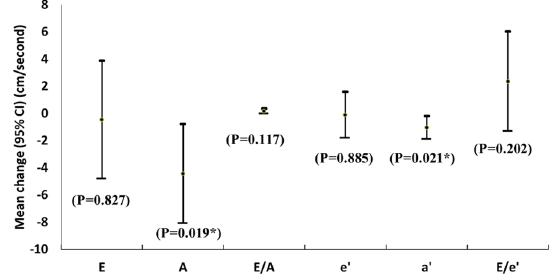
Fig. 4 Mean changes and its 95% confidence interval (CI) of trans-mitral of pulsed wave Doppler, and tissue Doppler at lateral mitral annulus variables before and after anesthesia with 1 MAC sevoflurane, E; E wave maximum velocity (cm/sec), A; A wave maximum velocity(cm/sec), E/A; ratio between A and E, a’; a’ wave maximum velocity(cm/sec), e’; e’ wave maximum velocity(cm/sec), E/e’; ratio between E and e’. * Denotes